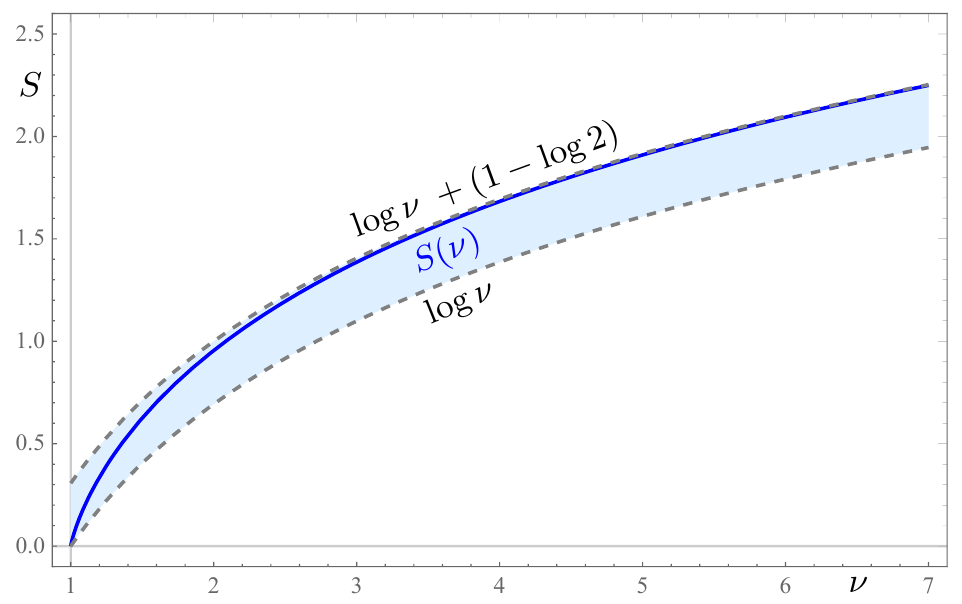
Figure 10 . Bounds on the entanglement entropy . The plot shows how the contribution S ( (cid:23) ) to the entanglement entropy coming from a single entangled pair is bounded from below by log (cid:23) and from above by log (cid:23) +(1 (cid:0) log 2). For large (cid:23) , the asymptotic behavior is S ( (cid:23) ) (cid:24) log (cid:23) +(1 (cid:0) log 2) (cid:0) O ( (cid:23) (cid:0) 2